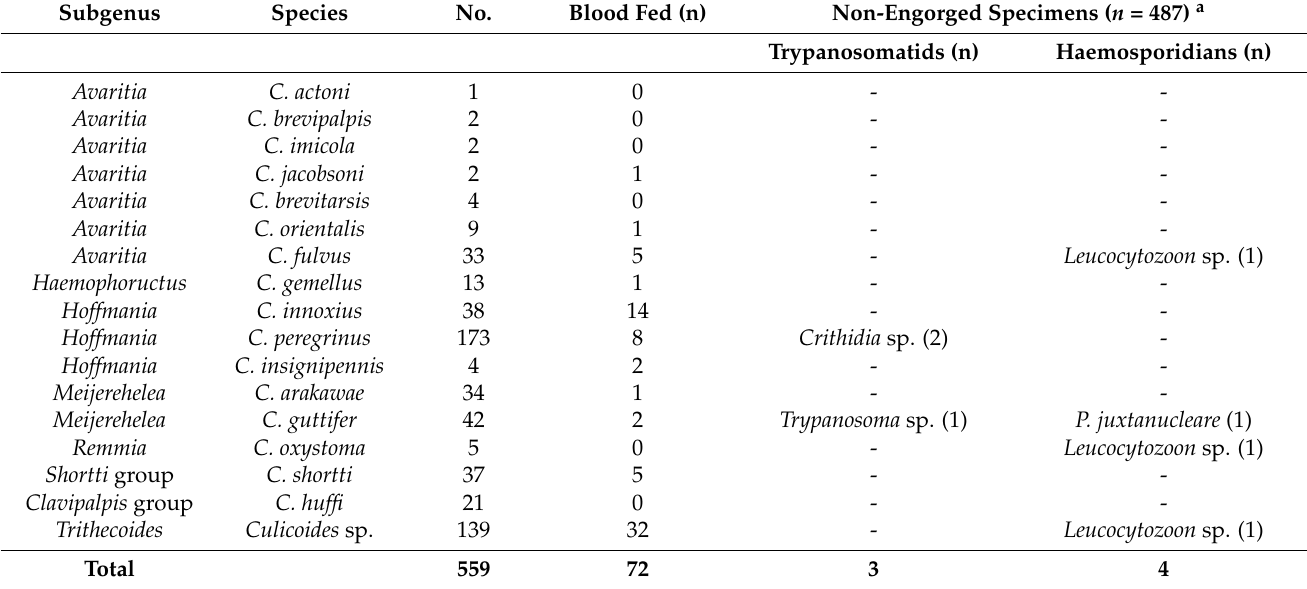
Table 2. Species Abundance, Number of Blood Fed, and Parasitic Detection Collected in Thai Culicoides biting midges, from Phatthalung province, southern Thailand.